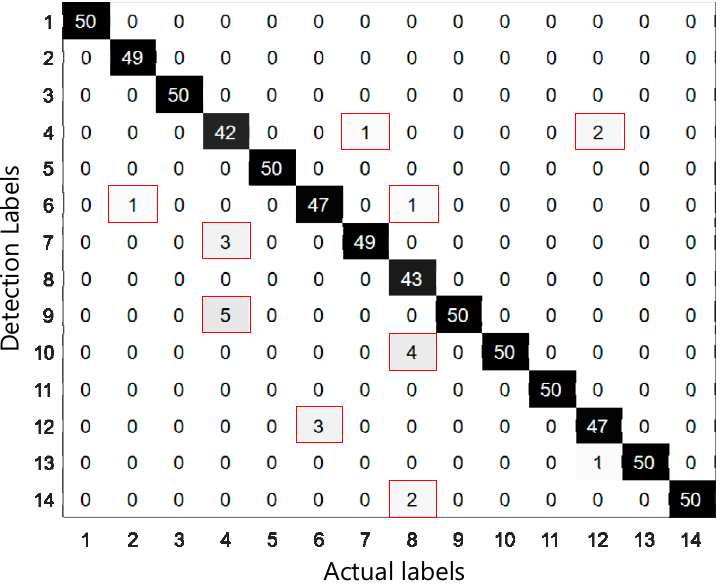
Figure 14. The confusion matrix of the test data in Random Forest (RF).